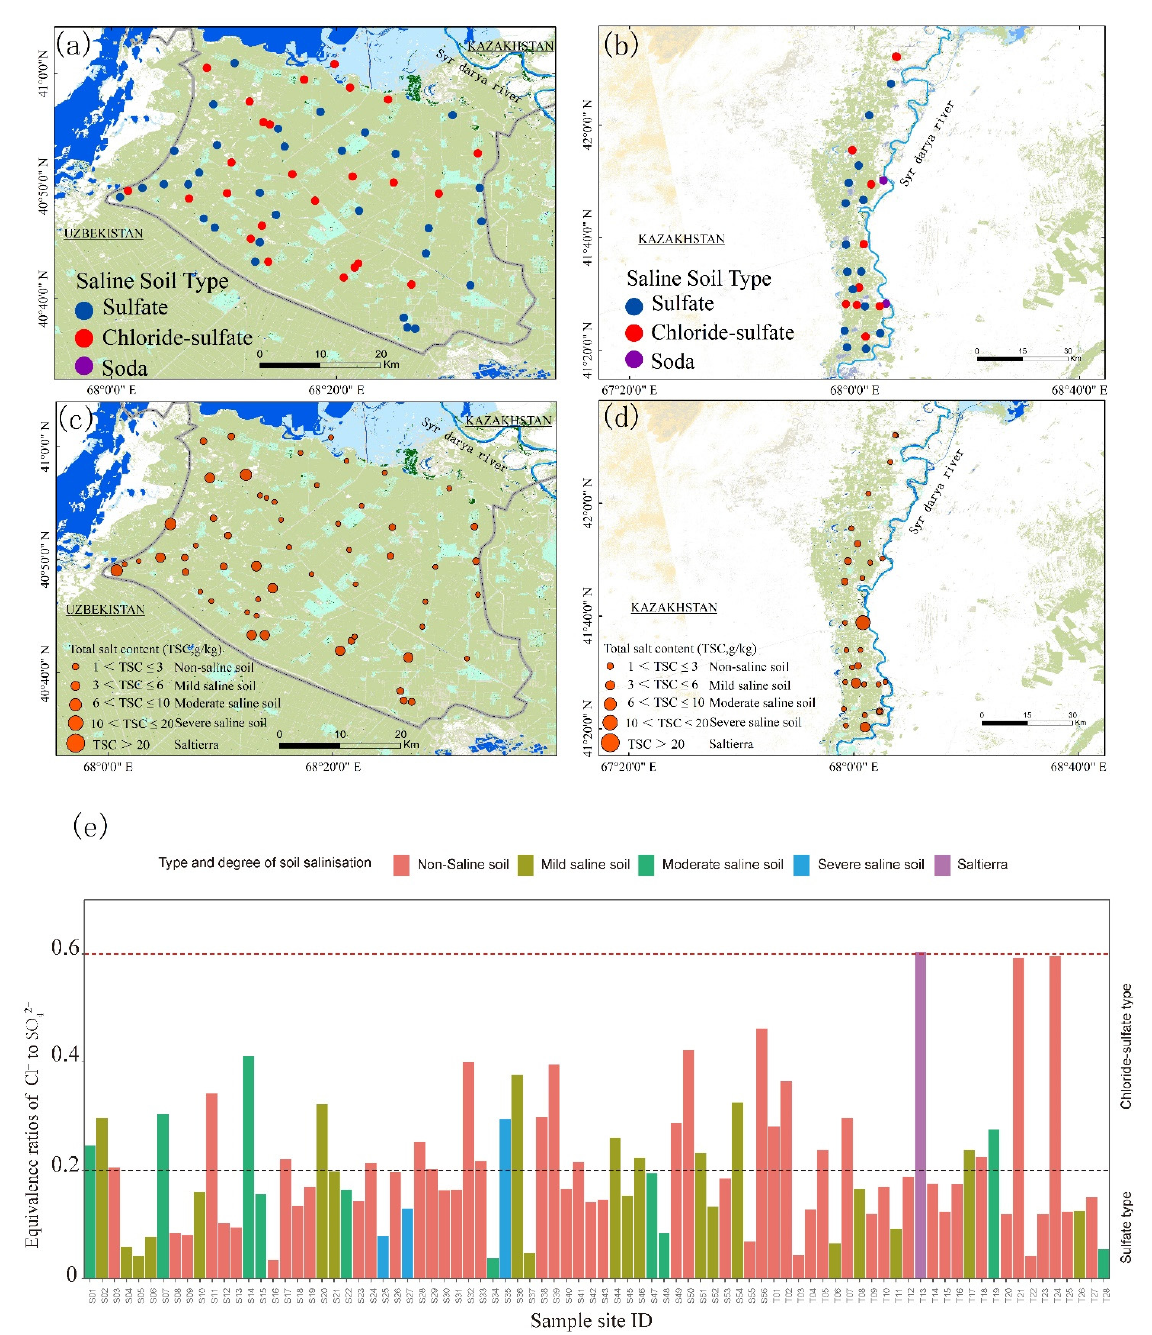
Figure 5. ( a ) The spatial distribution of saline soil type in Mahtaaral district; ( b ) The spatial distri- bution of saline soil type in Shardara district; ( c ) The spatial distribution of soil salinity levels in Mahtaaral district; ( d ) The spatial distribution of soil salinity levels in Shardara district; and ( e ) The Cl − /SO4 2 − equivalent ratio of sample sites.